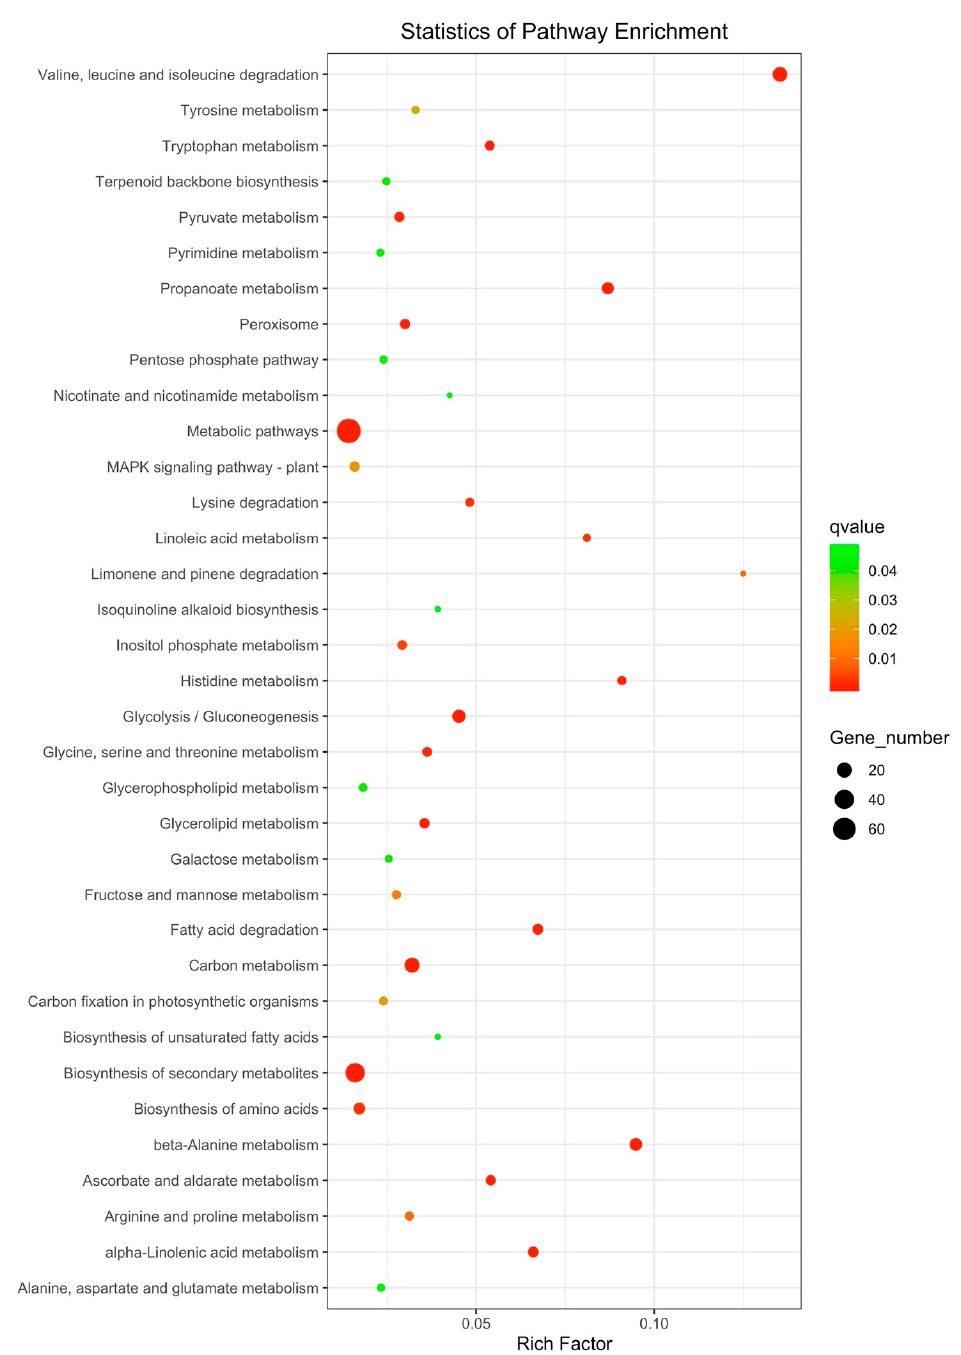
Figure 4. KEGG pathways enriched for up-regulated DEGs in K 326 Wz/Wz inoculated with the Wz-Wz isolate of P. nicotianae compared to inoculated Hicks. The y -axis indicates the name of the KEGG pathway. The dot size means the gene number. The dot color indicates the q -value.